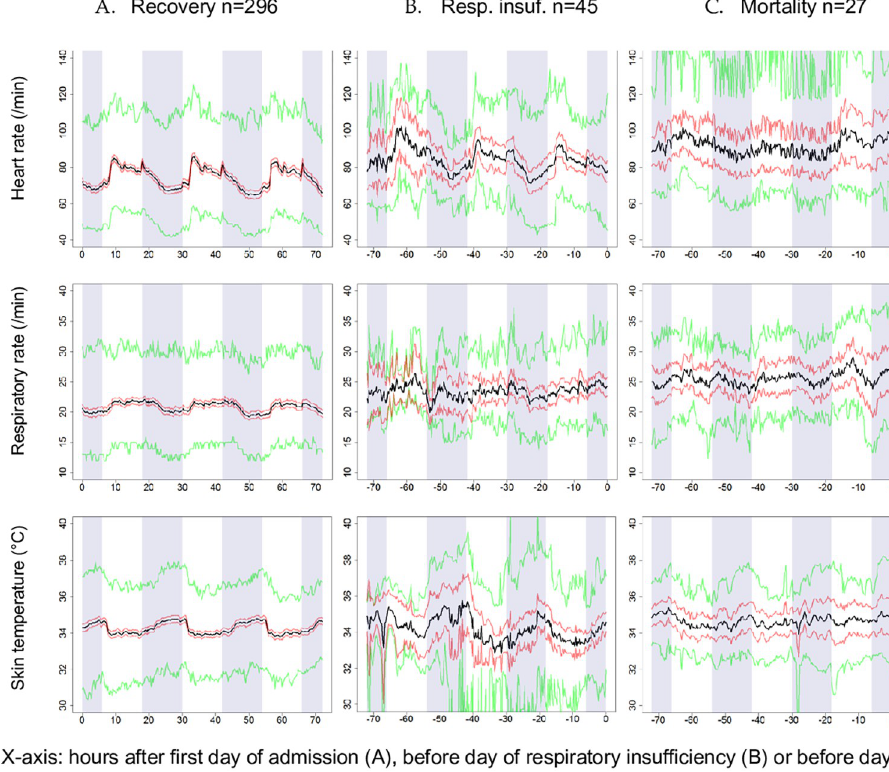
Fig 2. Mean of vital signs during three day observation period in each